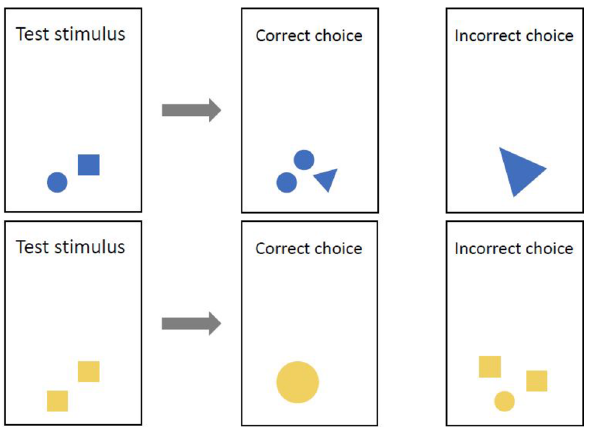
Figure 3. Example for a test stimulus and the corresponding two choice stimuli during addition (blue) and subtraction